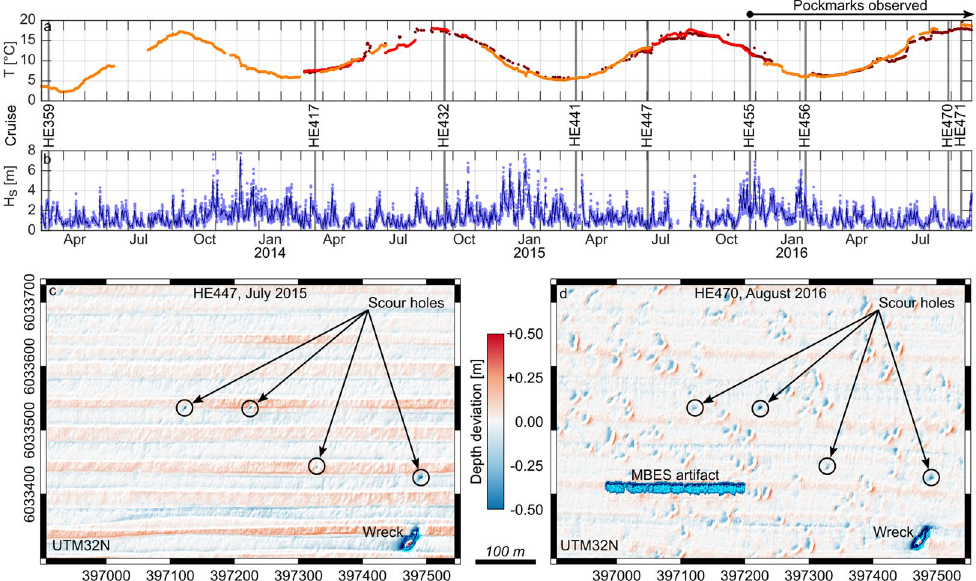
Figure 3. Emergence of the Helgoland Reef pockmarks. ( a ) Time series of bottom water temperature records from three stations in the German Bight. ( b ) Time series of significant wave height at Helgoland Reef from model hindcast. The data were provided by the COSYNA system 34 operated by Helmholtz-Zentrum Geesthacht Zentrum für Material- und Küstenforschung GmbH. ( c , d ) Zero-median bathymetries showing the emergence of the pockmarks. For the complete record of MBES bathymetries see Supplementary Fig. S3. The maps in this figure were generated using QGIS Version 2.14.11 43